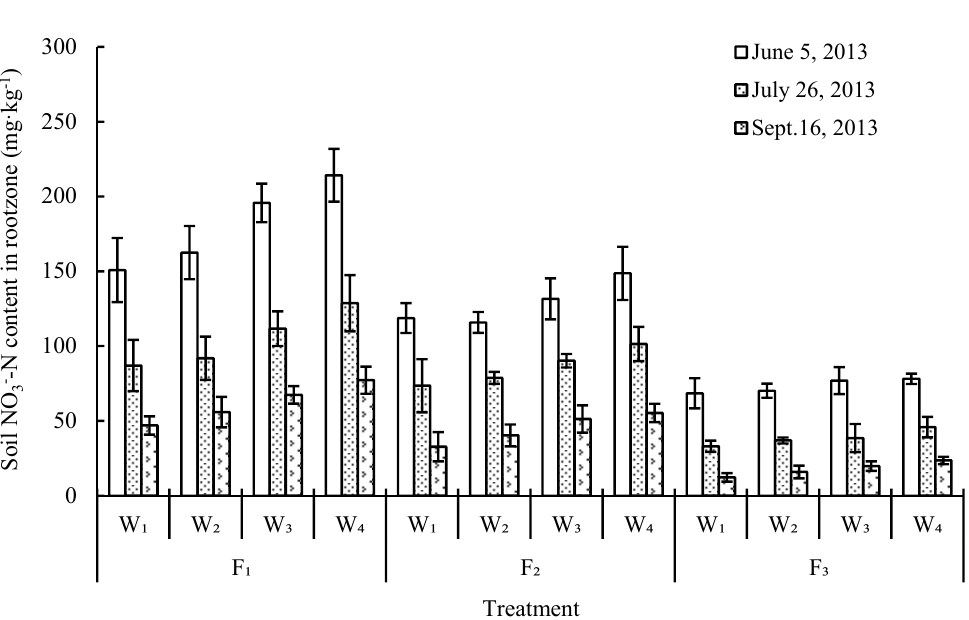
Figure 4. E ff ects of di ff erent water and fertilizer treatments on soil NO 3 − -N content in rootzone Figure 4. Effects of different water and fertilizer treatments on soil NO3 ‐ ‐ N content in rootzone (40~60 (40~60 cm) of young apple trees on 5 June, 26 July and 16 September in cm) of young apple trees on June 5th , July 26th and September 16th in 2013.